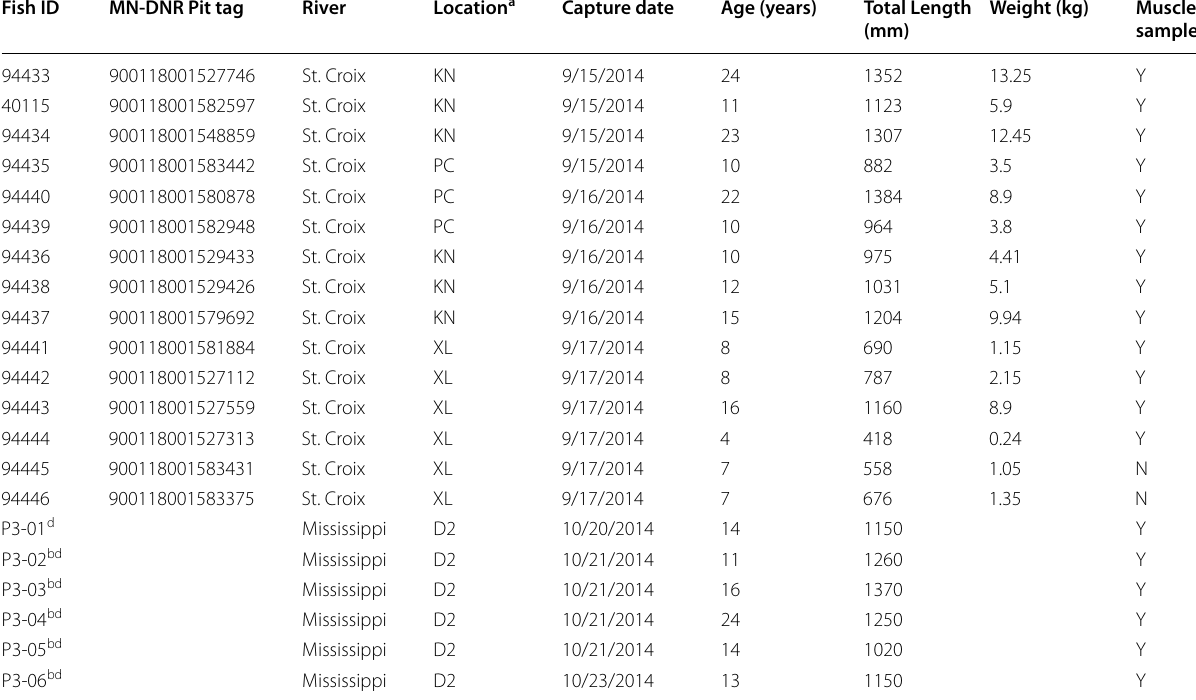
Table 1 Capture and morphometric data for lake sturgeon from the St. Croix and Mississippi